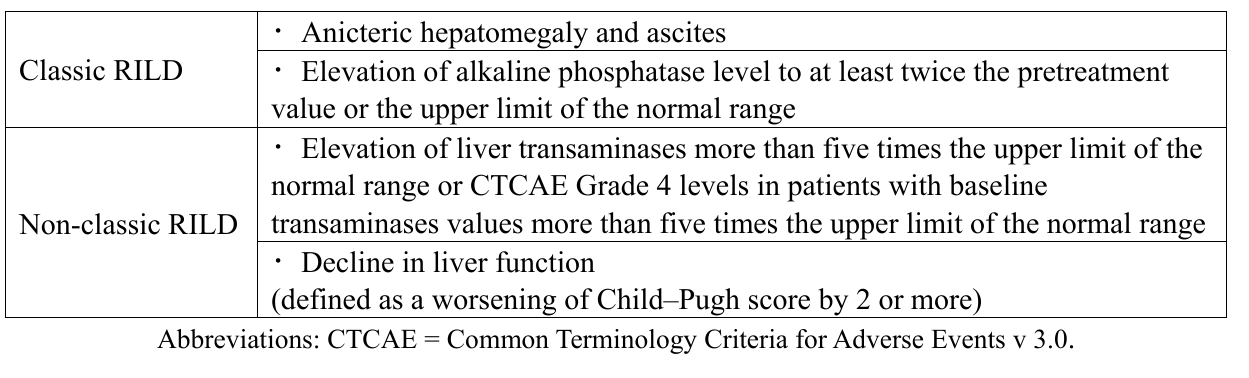
Table 1. Radiation-induced liver disease (RILD)